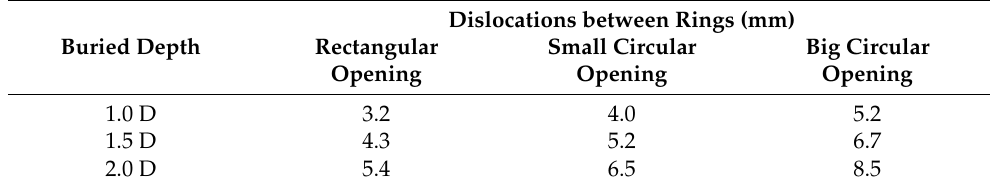
Table 3. Dislocations between adjacent rings.